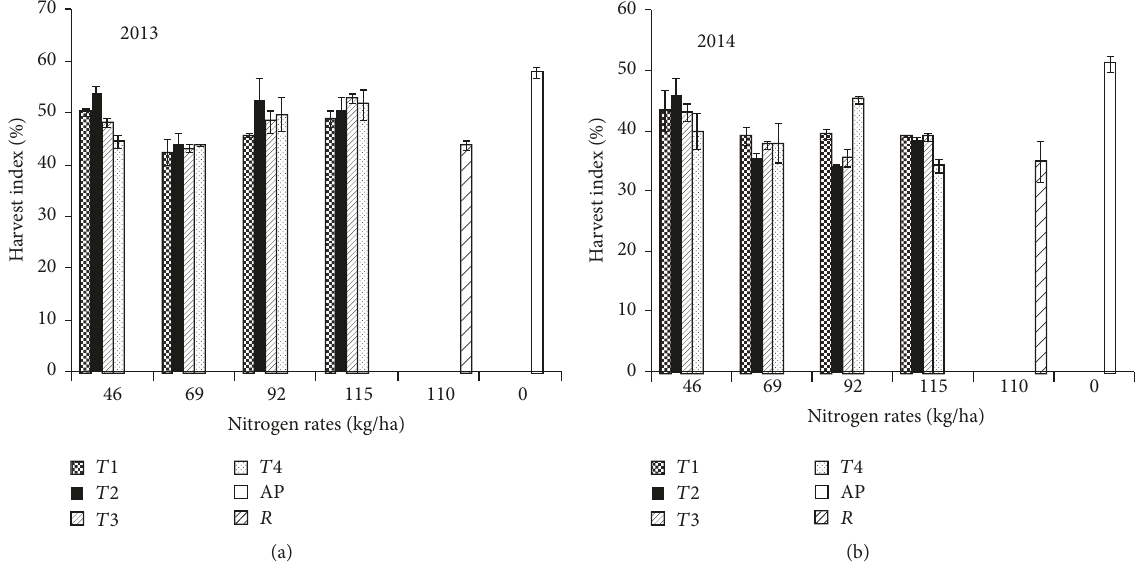
Figure 7: The effect of N rate and time of application on harvest index of maize in 2013 and 2014 cropping seasons.